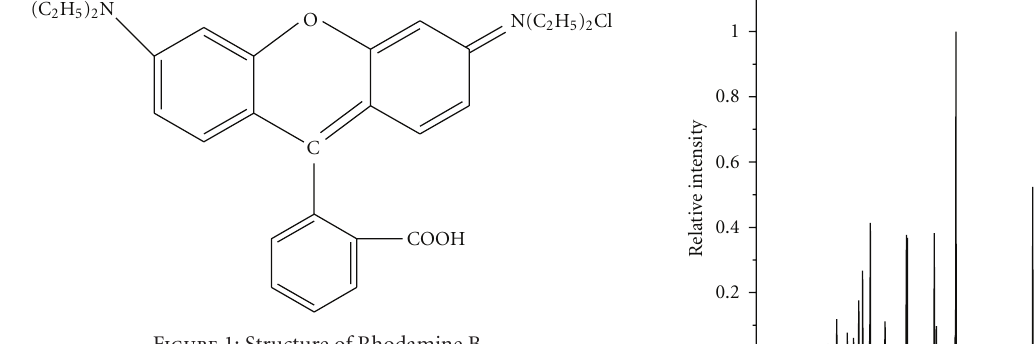
Figure 1: Structure of Rhodamine B.